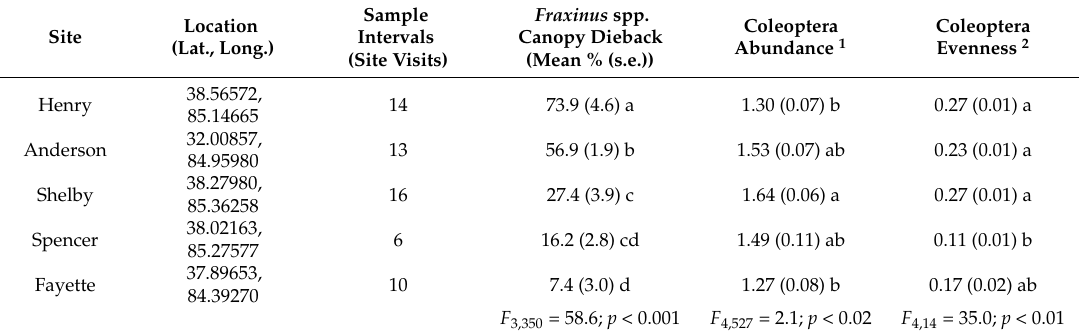
Table 1. Ash canopy dieback and coleopteran abundance at five sites in north-central Kentucky used to evaluate the colopteran community associated emerald ash borer-induced ash decline. Means followed by the same letter do not differ ( α =